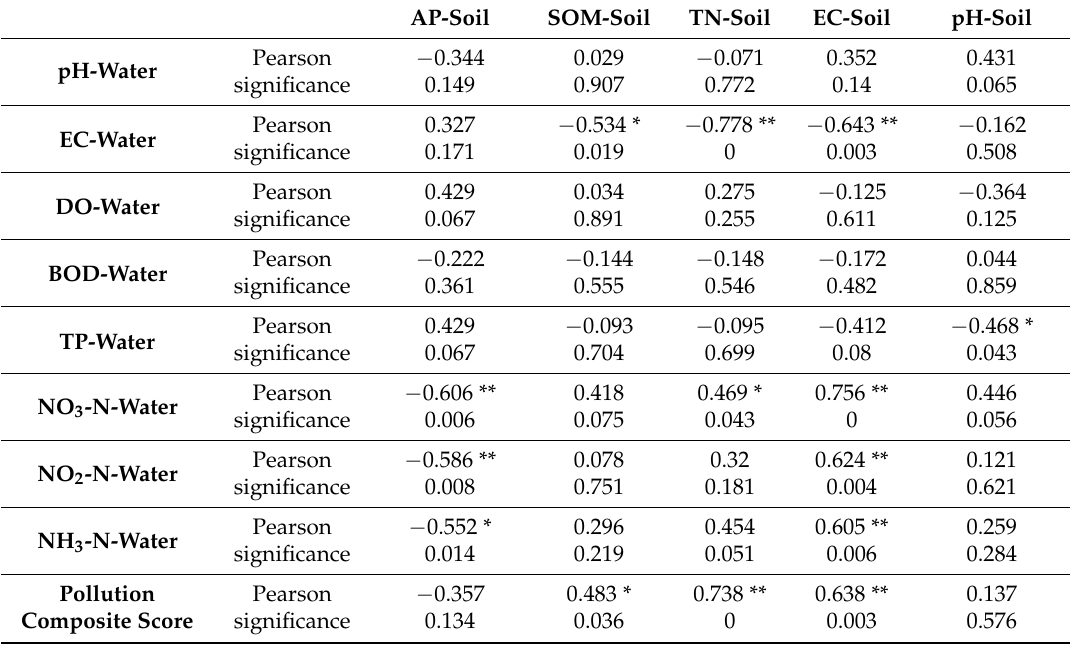
Table 10. The relationships between soil and water quality in dry